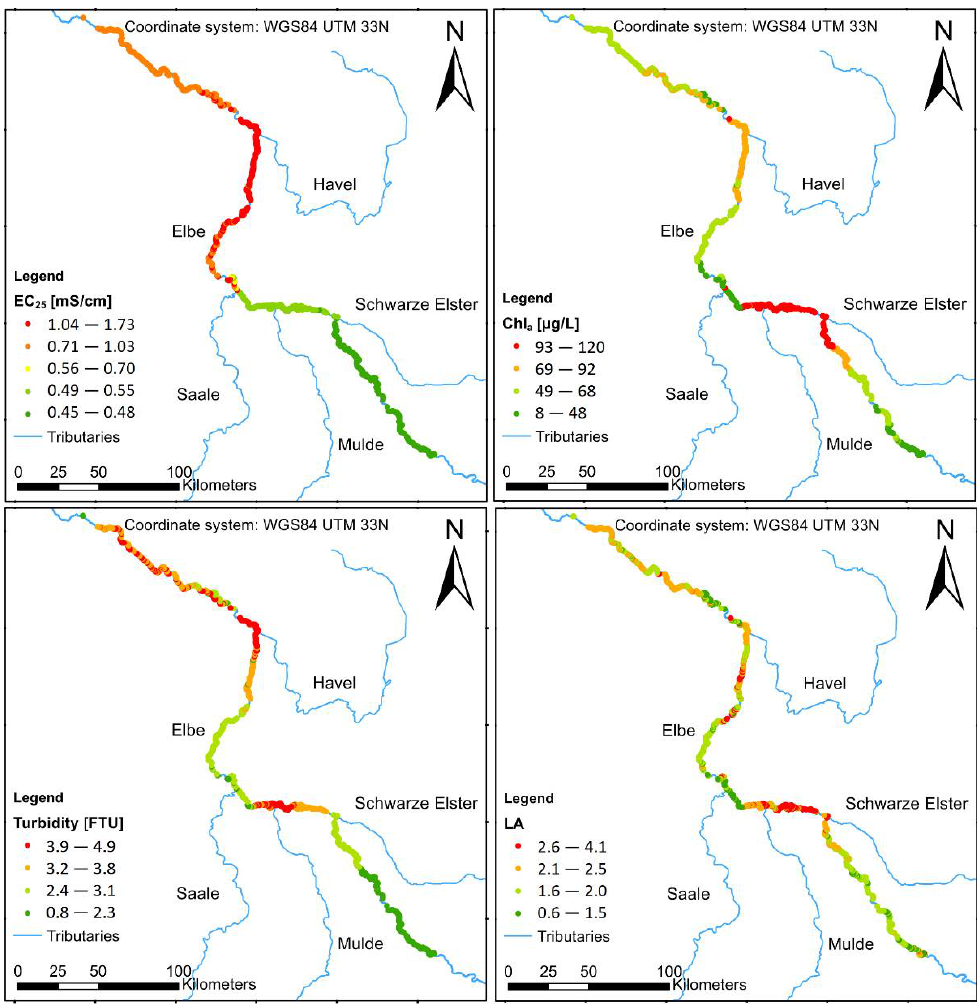
Figure 5. EC 25 ( top left ), Chl a ( top right ), Turbidity ( bottom left ) and LA ( bottom right ) concentra- Figure 5. EC 25 (top left), Chl a (top right), Turbidity (bottom left) and LA (bottom right) concentra-